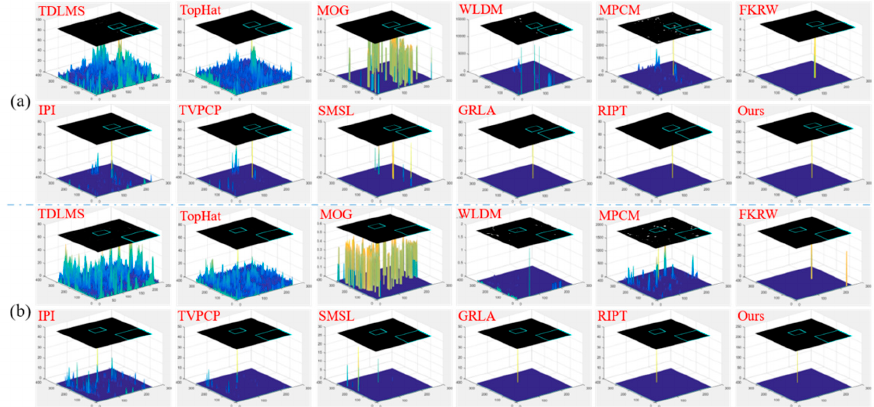
Figure 7. Detection results obtained by the proposed method over deep-space scenes compared with 11 comparative approaches. For better observation, the target images are integrated with their 3D stereogram. ( a ) Representative frame in Sequence 1. ( b ) Representative frame in Sequence 2. Remote Sens. 2020 , 12 , x FOR PEER REVIEW